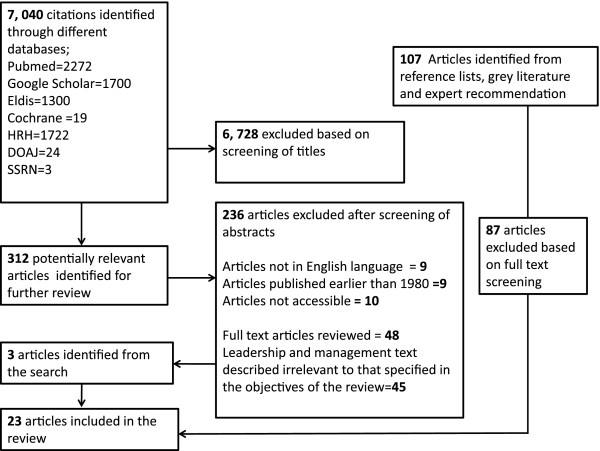
Exclusion criteria.